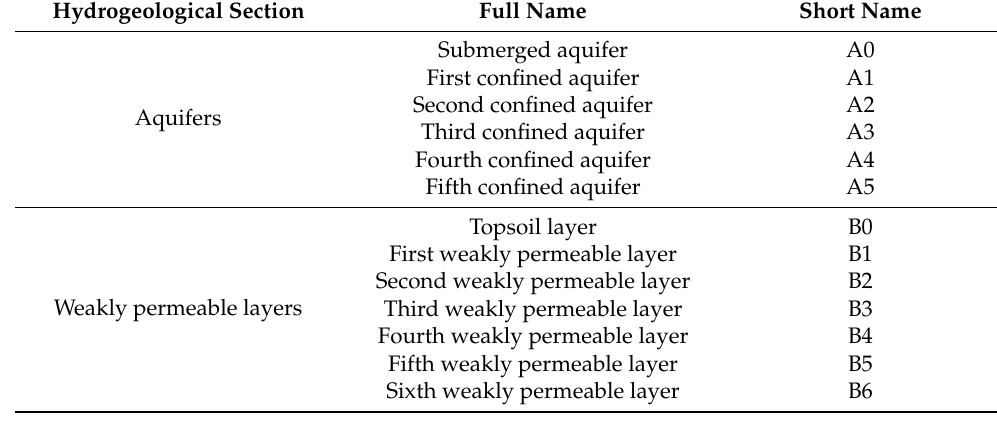
Table 1. The List of Hydrogeological Section.